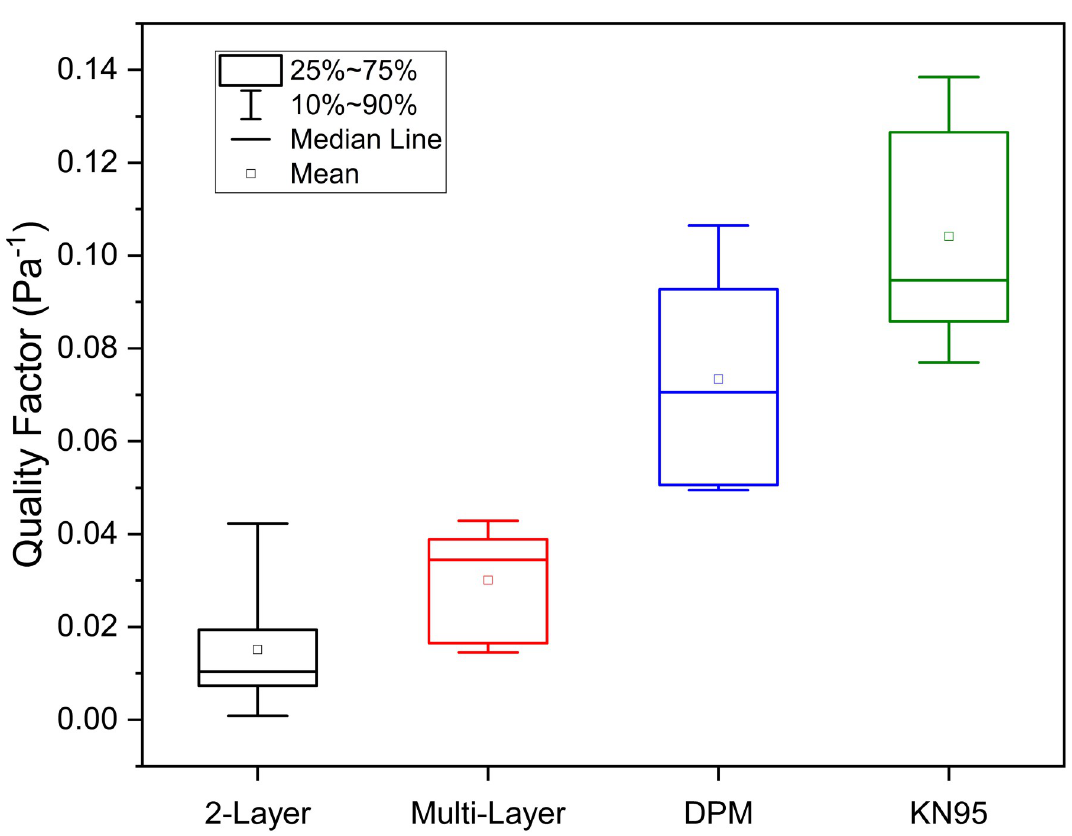
Fig 10. QF values for the fabric 2-layer, multi-layer, disposable procedure/surgical and KN95 mask groups. As the face velocities used in filtration testing for the N95 FFR group were dissimilar to the other three mask groups, their QF values were not plotted for comparison in this figure. DPM = disposable procedure